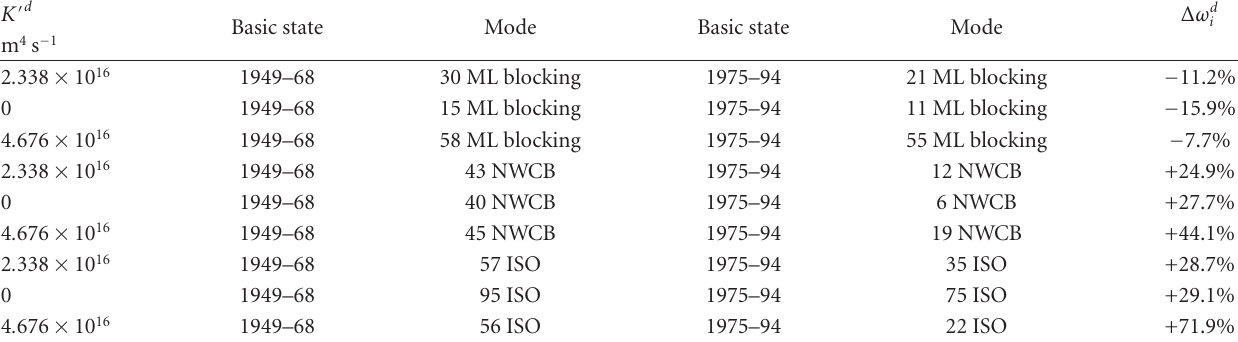
Table 5: Changes in growth rates, Δ ω d , for leading blocking, NWCB, and ISO modes when basic state is changed from 1949–68 basic state i to 1975–94 basic, for di ff erent dissipation parameters, K (cid:3) d